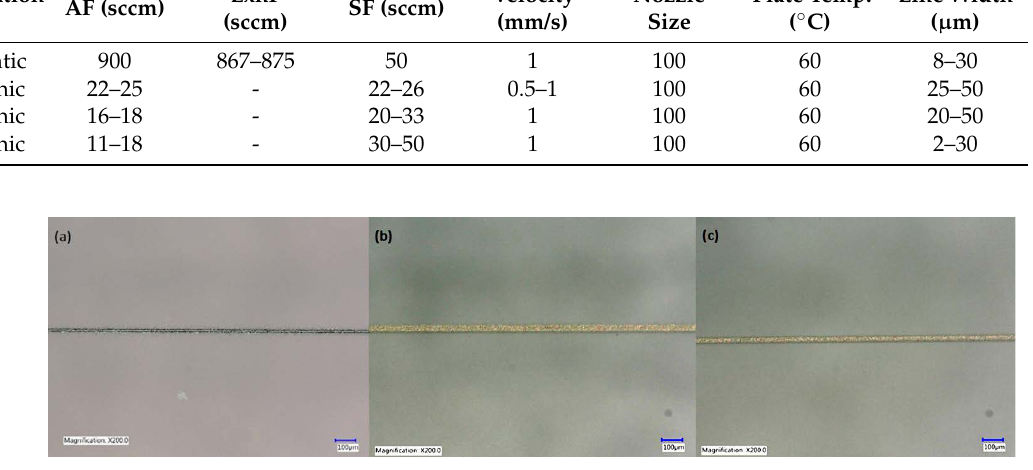
Figure 3. Examples of well-printed lines: ( a ) Clariant Prelect TPS50 (13 µ m); ( b ) UTDots Ag25X (34 µ m); ( c ) UTDots Ag40X (33 µ m).